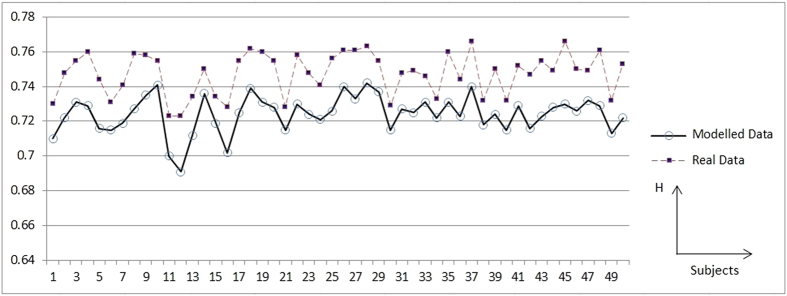
Means of Hurst exponent variation for real and modelled DNA walks in case of different subjects.